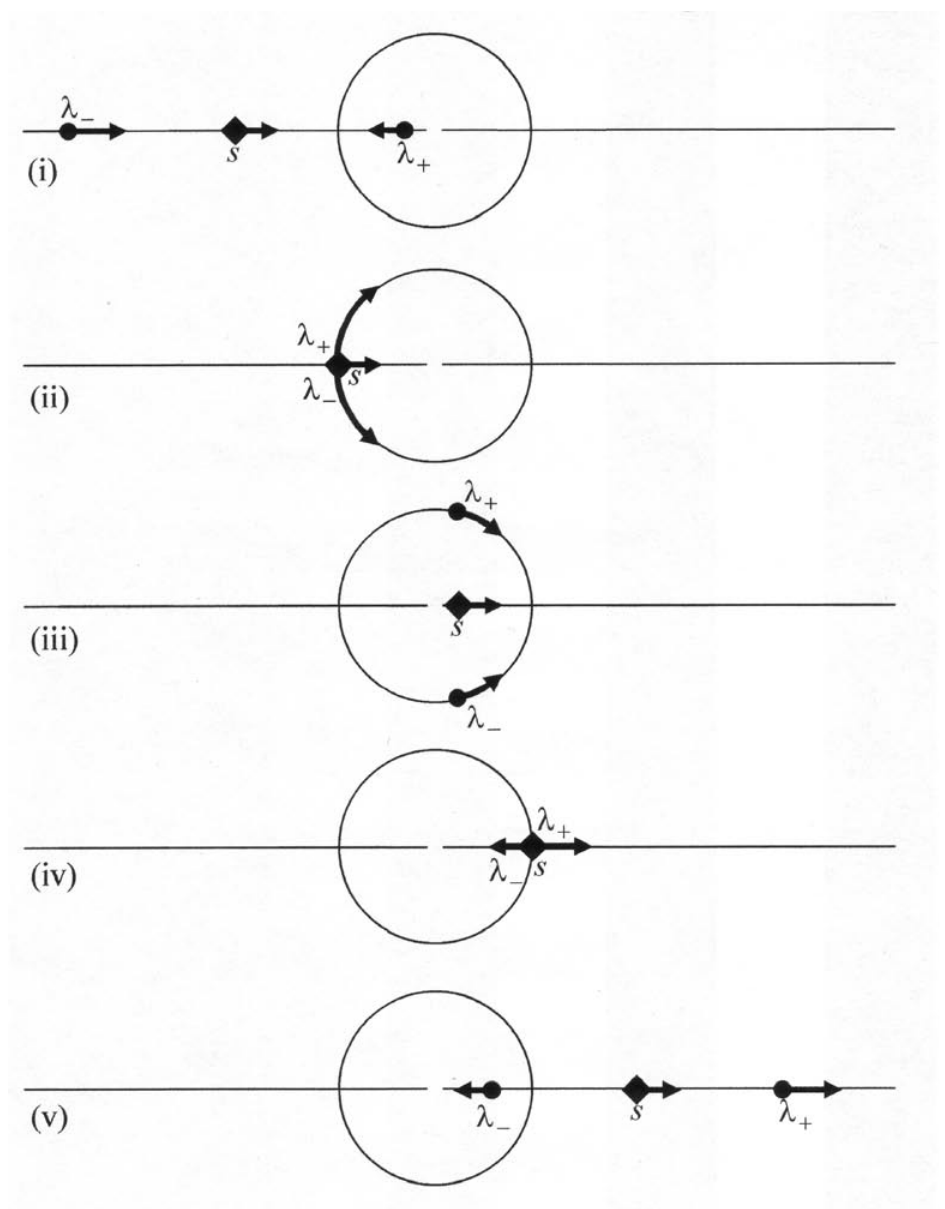
Figure 3 Behaviour of the eigenvalues λ – and λ+ as the semi-trace s increases across the real numbers. (i) is typical of Keplerian telescopes, (iii) of human eyes and (v) of Galilean telescopes. (iv) represents all thin and all elementary systems. ^ tion of the vertical line at s and the circle